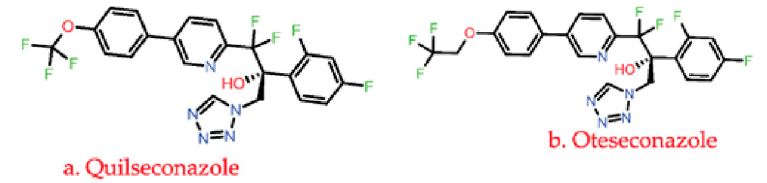
Figure 7. Two-dimensional structure of drugs under tetrazole group.